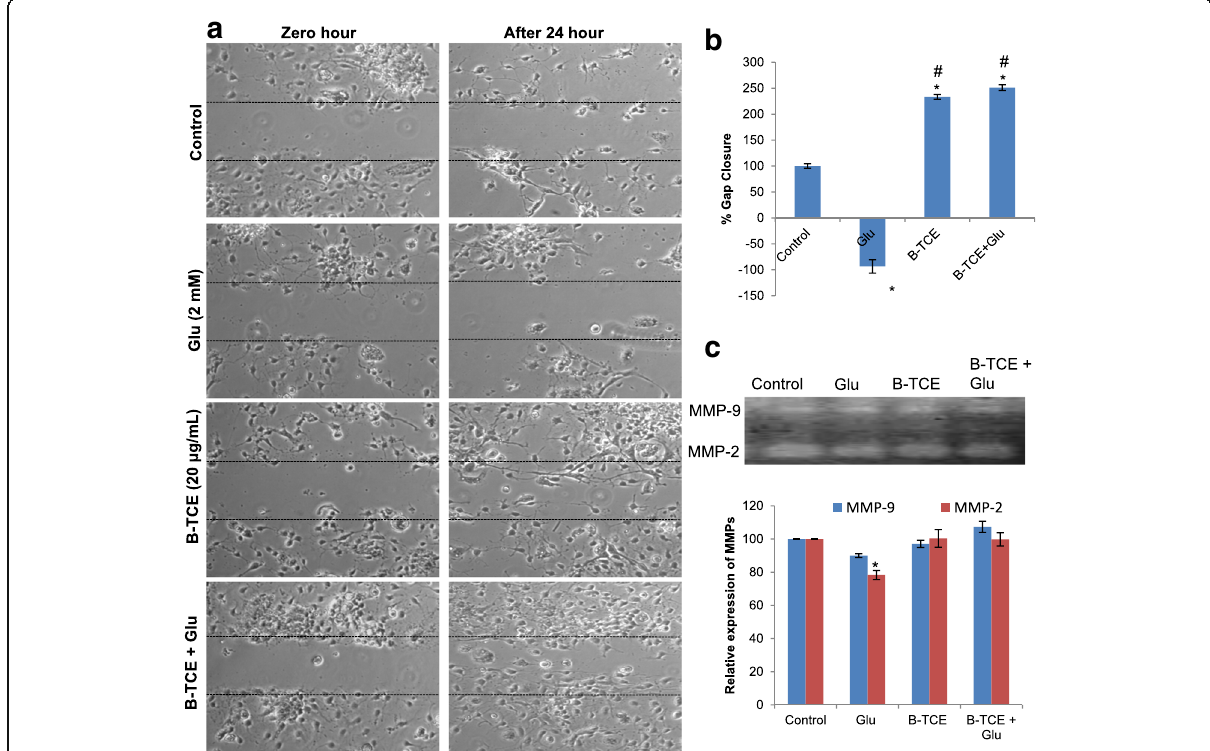
Fig. 6 B-TCE pretreatment promoted migration into the scratched area under glutamate-induced excitotoxic insult. a ) Phase contrast micrographs of Control, Glutamate (2 mM), B-TCE (20 μ g/mL) and B-TCE + Glu treated primary cerebellar neurons captured at 0 and 24 h of treatment. b ) Representative histogram showing percentage gap closure after 24 h of treatment c ) Gelatin zymogram showing MMP bands and histogram representing densitometric analysis of corresponding MMP bands. Data was compared between Control and other groups such as